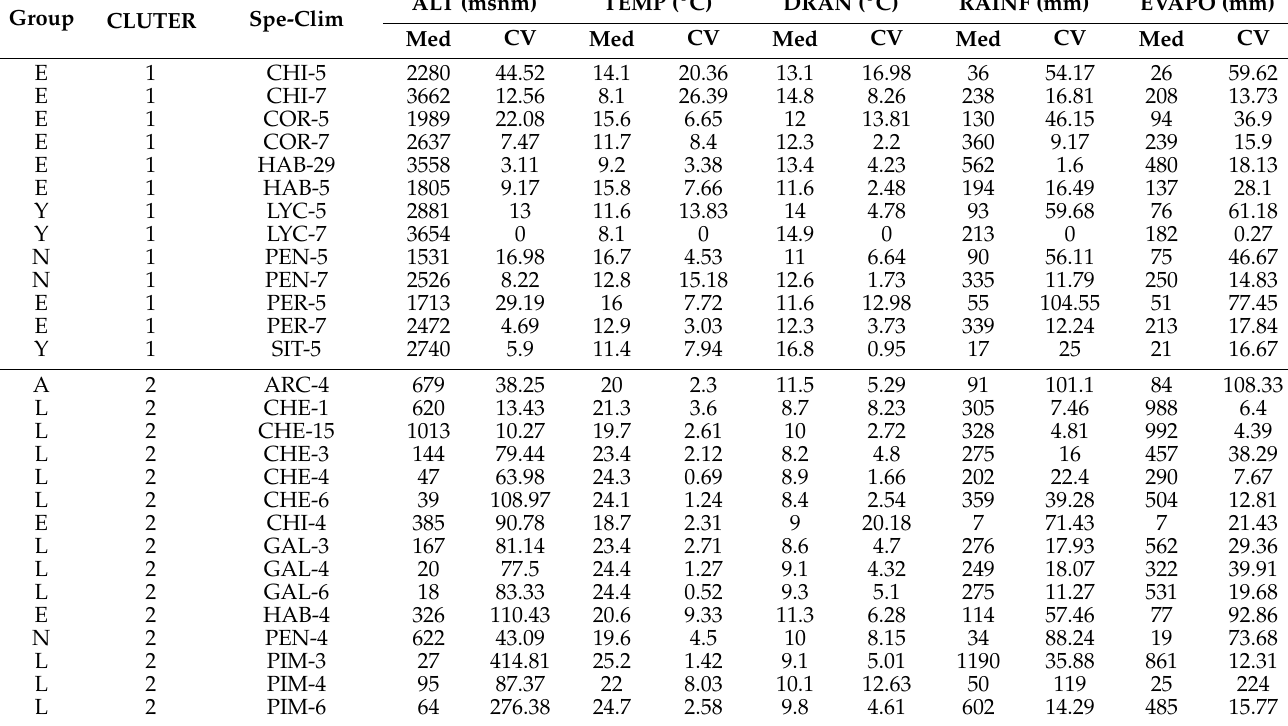
Table 3. Median (Med) and coefficient of variation (CV) of the ecological descriptors of the combinations of 16 wild and related tomato species by the 11 climatic types identified according to the formation of CA groups. Group = A (Arcanum), E (Ericopersicon), N (Neolicopersicon), Y (Section Lycopersicoides), L (Lycopersicon), and J (Section Juglandi- folia). Spe = species, Clim = climate type [31], ALT = altitude, TEMP = annual mean temperature, DRAN = mean diurnal range, RAIN = annual precipitation, EVAPO = annual evapotranspiration. JUG = S. juglandifolium , OCH = S. ochranthum , CHI = S. chilense , COR = S. corneliomulleri , HAB = S. habrochaites , HUA = S. huaylasense , LYC = S. lycopersicoides , PEN = S. pennelli , ARC = S. arcanum , CHM = S. chmielewskii , NEO = S. neorickii , CHE = S. cheesmaniae , GAL = S. galapagense , PIM = S. pimpinelifollium , PER = S. peruvianum , SIT = S. sitiens . Climate types: 1 = Af (tropical, rainforest), 2 = Am (tropical, monsoon), 3 = Aw (tropical, savannah), 4 = BWh (arid, desert, hot), 5 = BWk (arid, desert, cold), 6 = BSh (arid, steppe, hot), 7 = BSk (arid, steppe, cold), 9 = Csb (temperate, dry summer, warm summer), 12 = Cwb (temperate, dry winter, warm summer), 15 = Cfb (temperate, no dry season, warm summer), 29 = ET (polar,